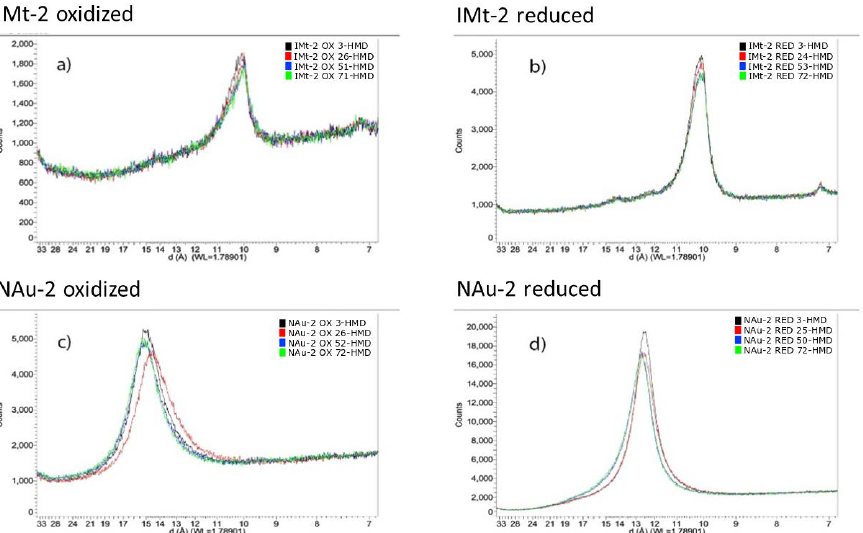
Figure 3. X-ray diffraction patterns showing the 001 basal reflection for the clay minerals ( a ) IMt-2